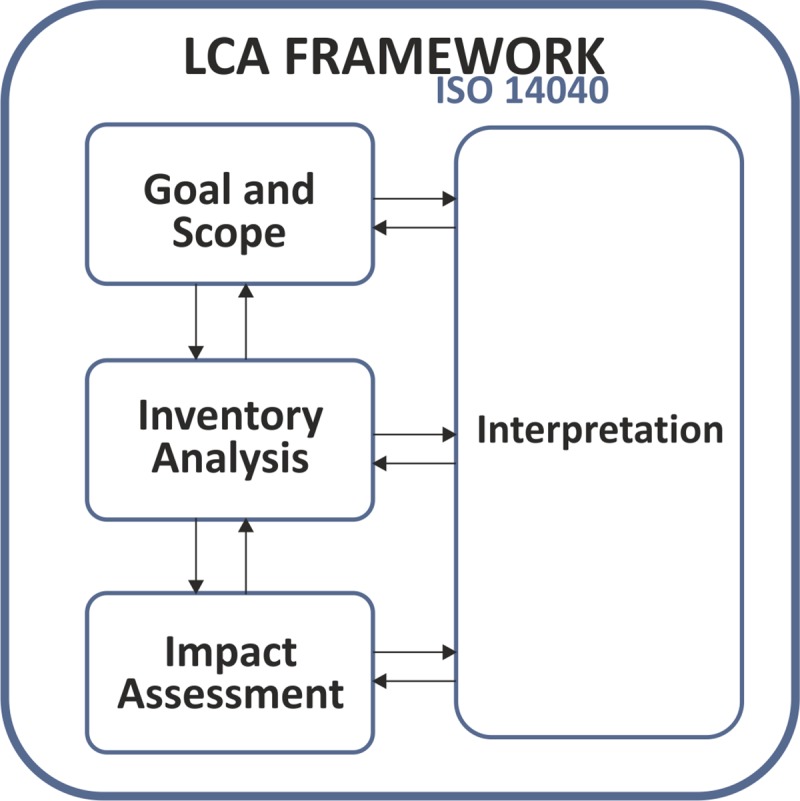
ISO 14040:2006.Adapted from [32].